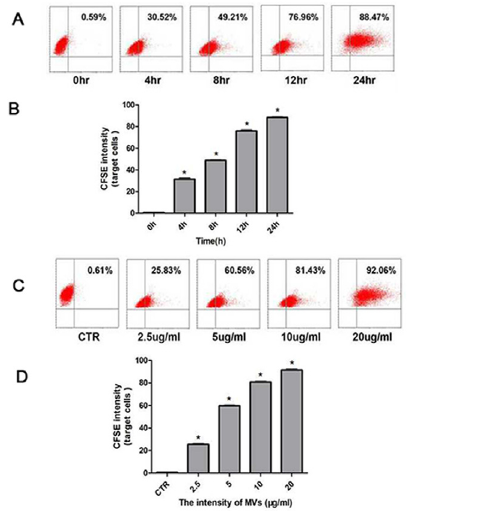
Fig 4. MSC-MVs were engulfed by HUVECs dose- and time-dependent. (A) CFSE-labeled MSC-MVs were added to the culture medium of HUVECs at a dose of 10 μ g/ml and the cells were collected at different time-points. (B) Flow cytometry graphs analysis the mean fluorescent values of tripical experiments, error bars are +/- S.D., * P < 0.001; (C) HUVEC culture was maintained for 12 hours in the presence of graded concentrations of MSC-MVs. X-axis: CFSE fluorescence intensity; Y-axis: forward scatter corner signals showing the size of the gated events. (D) MVs internalization is dose-dependent ( * P < 0.001, n =